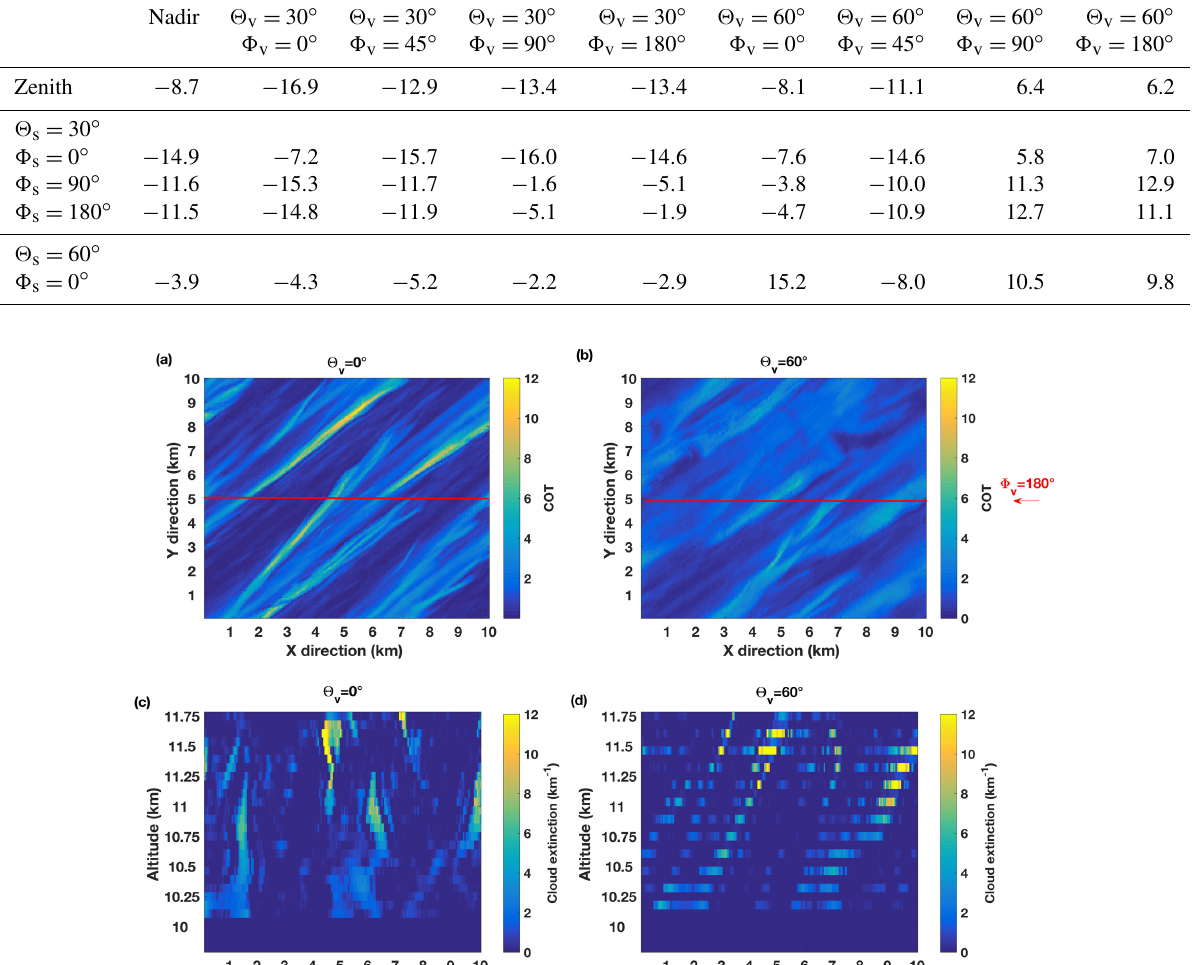
Table 2. 3-D effects, in percentage relative to the 3-D reflectance, averaged over the 10km field for various viewing zenith and azimuth angles ( (cid:50) v and (cid:56) v , respectively) and solar zenith and azimuth angles ( (cid:50) s and (cid:56) s , respectively).